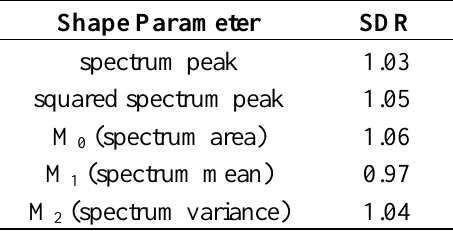
Table 4. Results of shape parameters evaluation by SDR criterion for free-rising bubble flow encapsulated by a Plexiglas pipe.